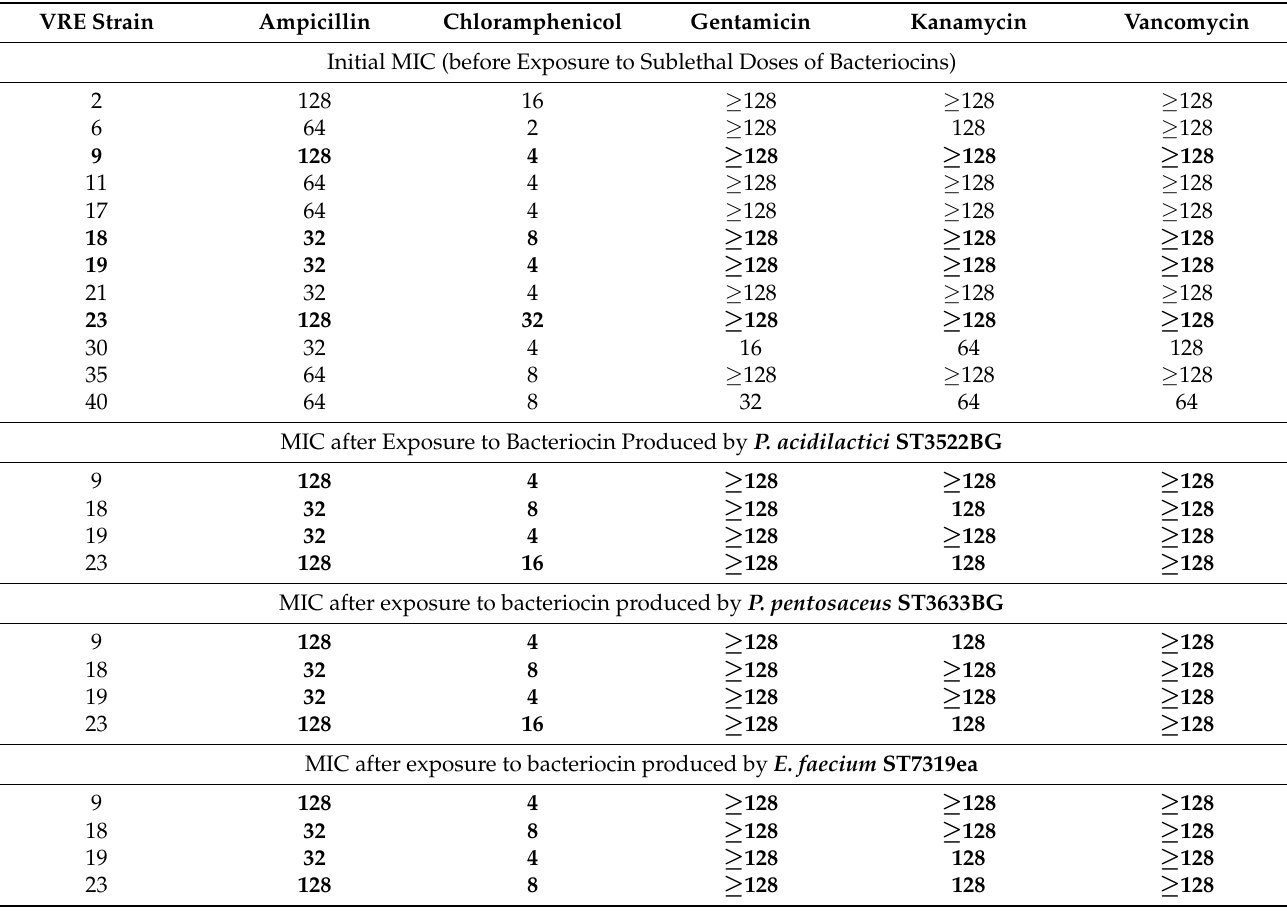
Table 2. Long-term exposition of selected VRE strains to the bacteriocins produced by P. acidilactici ST3522BG, P. pentosaceus ST3633BG, and E. faecium ST7319ea. The test organisms were grown in the MRS supplemented with 50 AU mL − 1 (final concentration) for 30 days and at 37 ◦ C, and consequently, MIC was evaluated. In bold were highlighted VRE strains and antibiotic’s MIC from initial screening applied in long term exposure to sublethal doses of studied